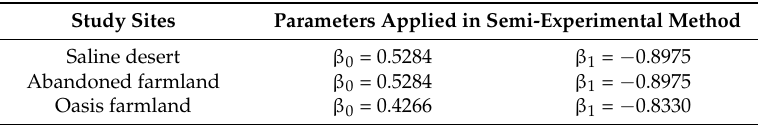
Table 1. Suitable parameters for the isolation of A a .